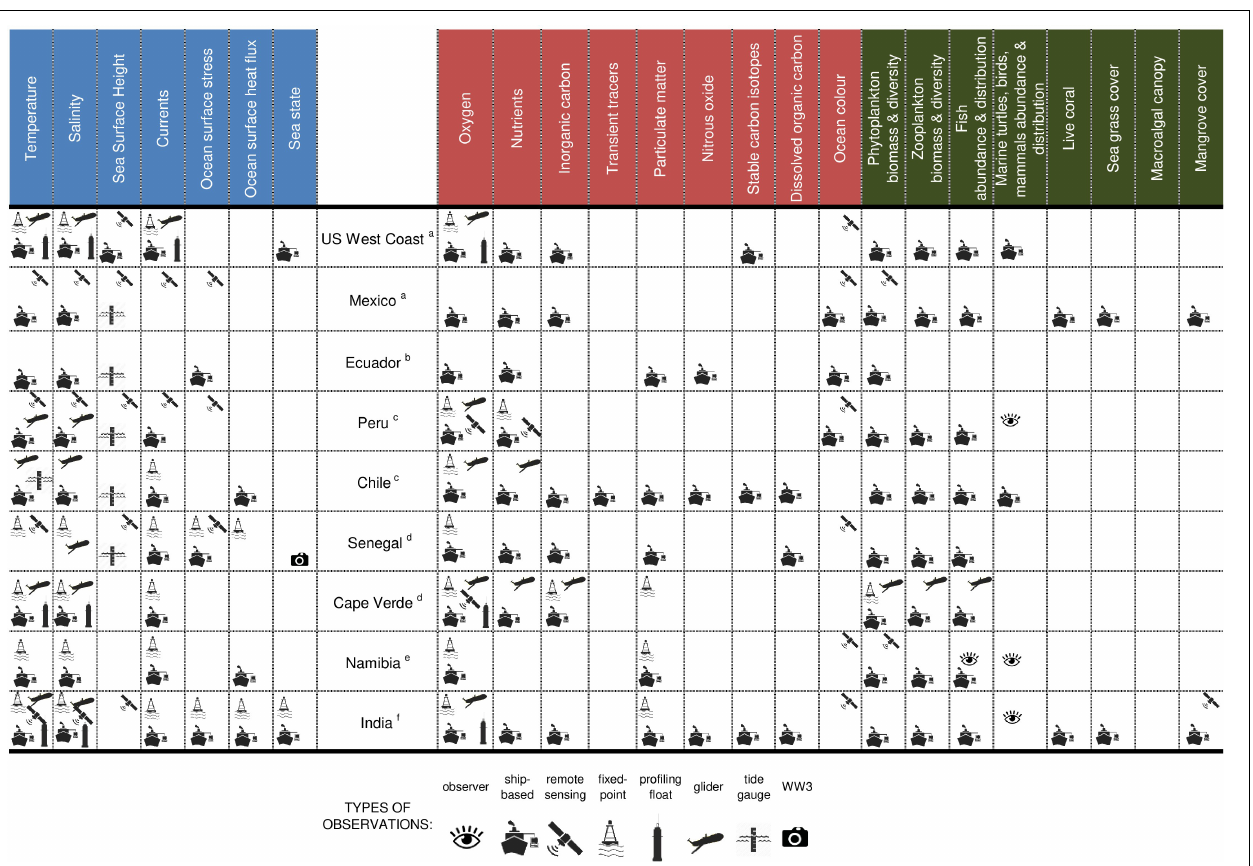
FIGURE 9 | Current status of essential ocean variable (EOV) measurements with respect to phenomena being monitored (see Figure 8 ) in all oxygen minimum zone (OMZ) regions. Different icons represent different observing approaches. Please note that the same symbol is used for hydrographic surveys and ships of opportunity lines (grouped under “ship-based”), one symbol for all: “fixed-point” observations (buoys, moorings), and one symbol for all “remote sensing” (airborne, satellite,